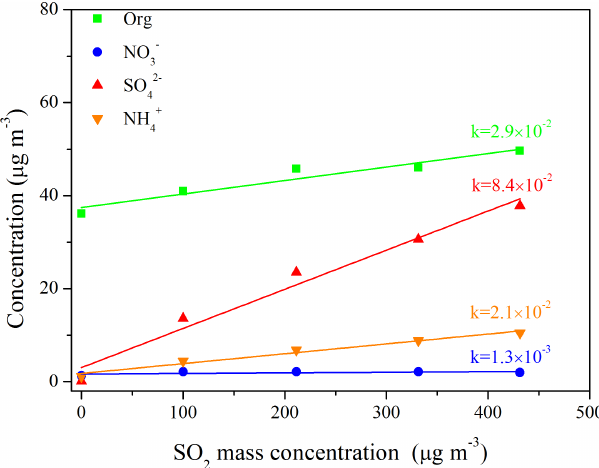
Figure 2. Linear relationship between the concentration of chem- ical species (i.e., organic (green), nitrate (blue), sulfate (red), and ammonium (orange)) and SO 2 under different SO 2 initial concen- tration conditions (Exps. GN, SGN1, SGN2, SGN3, and SGN4). Each line represents a linear fitting, and the k values are the corre- sponding slopes for each chemical